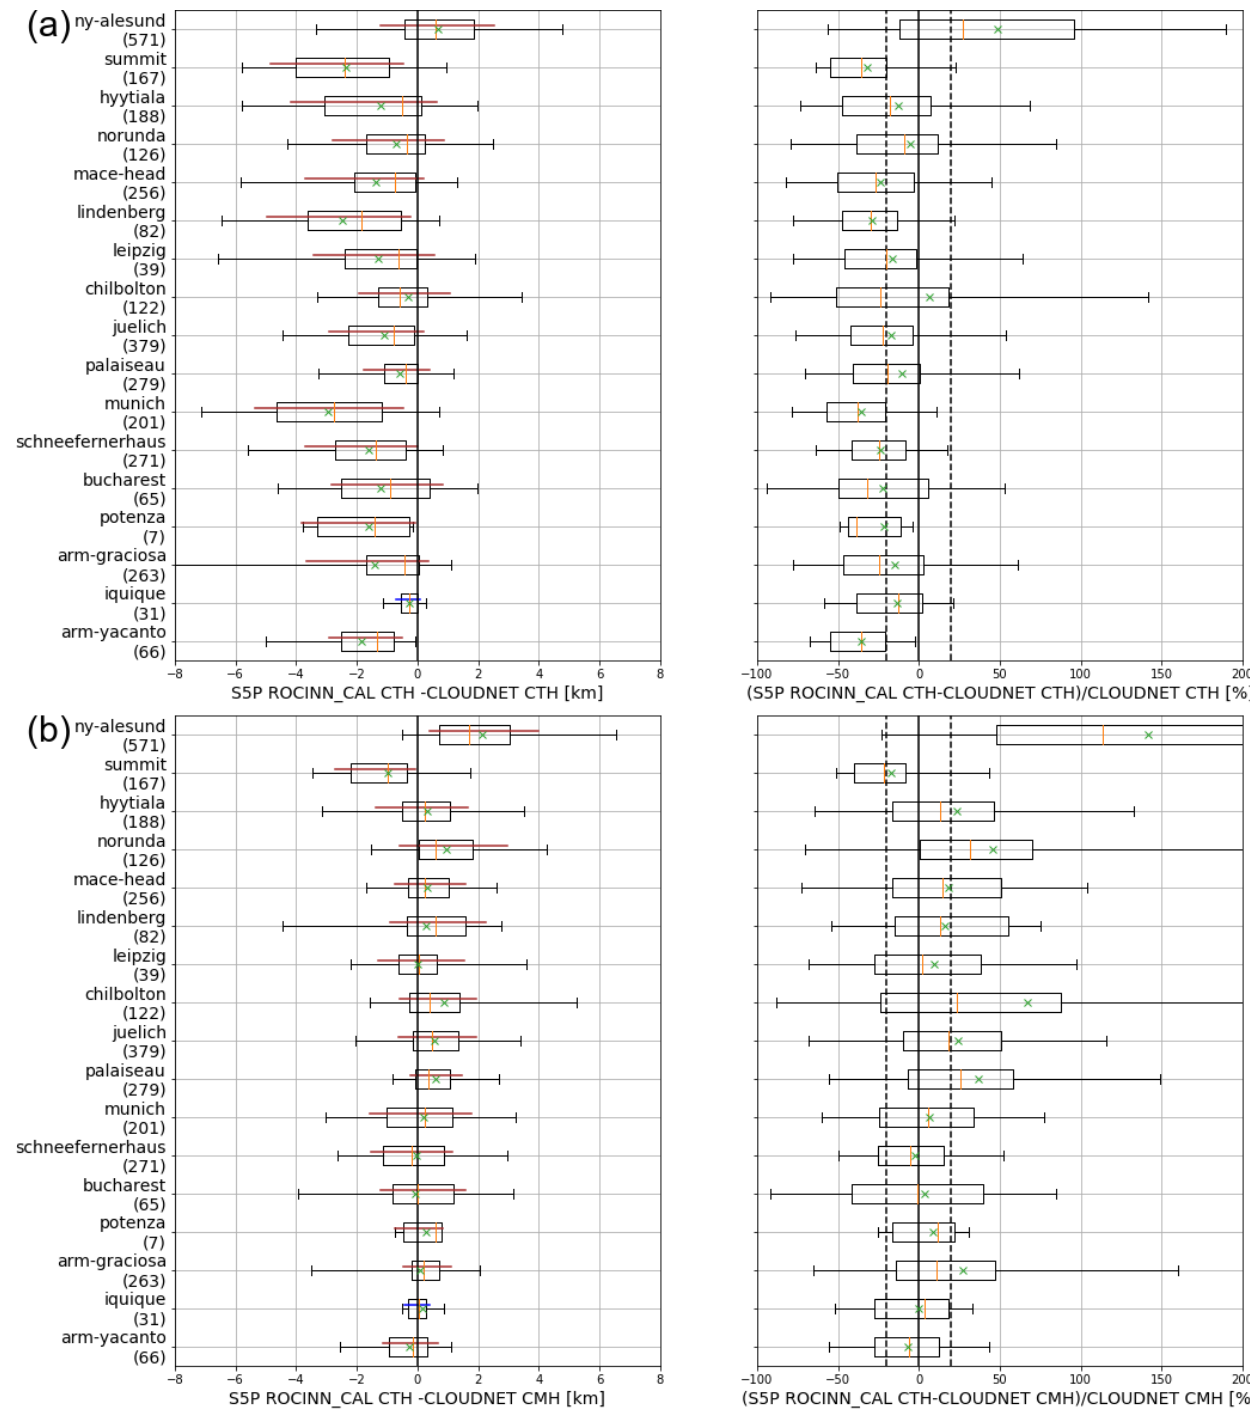
Figure 11. Panel (a) shows a boxplot of the difference (left) and of the relative difference (right) between S5P OCRA/ROCINN_CAL CTH and Cloudnet CTH. Panel (b) shows the same but between S5P OCRA/ROCINN_CAL CTH and Cloudnet CMH. Figure conventions are as follows. Box edges: first and third quartiles; line: median; whiskers: 5th and 95th percentiles; cross: median. Furthermore, a line corresponding to the central 68% interval is indicated. Its colour is brown when the 0.5 IP68 exceeds the dispersion requirement and blue